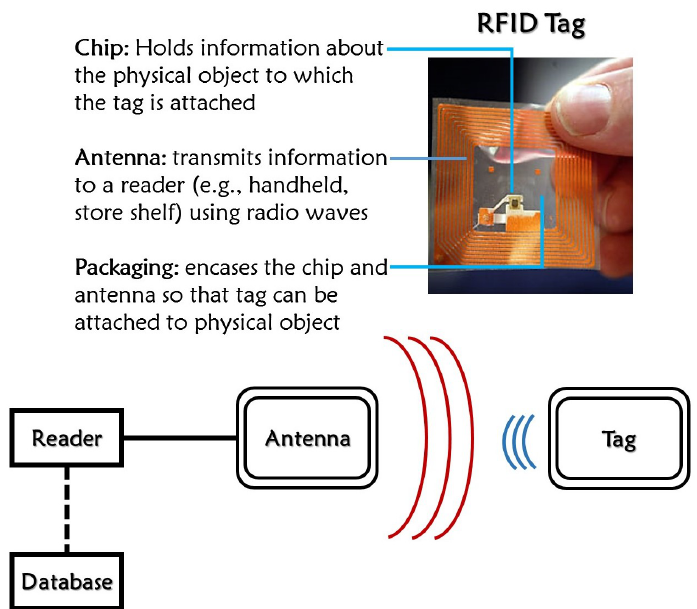
Figure 1. Wireless sensor scenario (radio frequency identification (RFID)